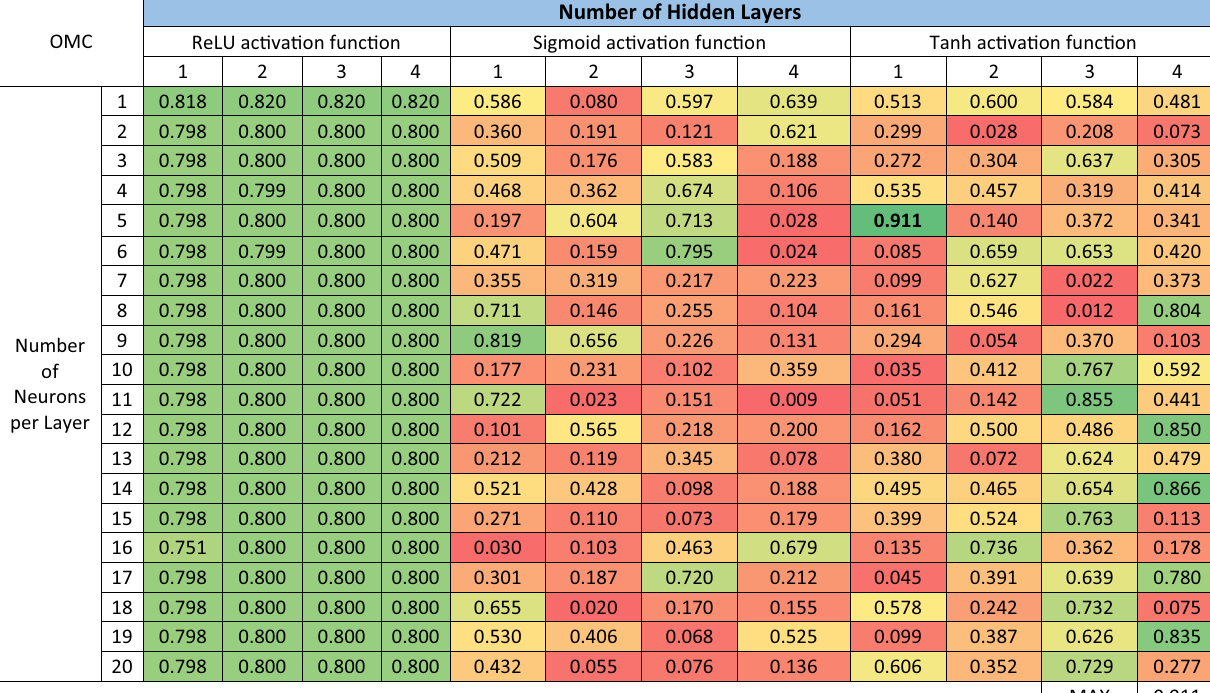
Number of Hidden